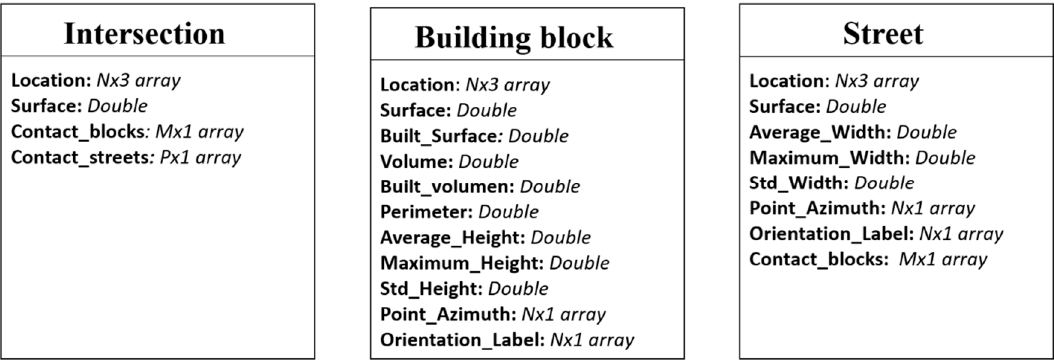
Figure 6. Three different classes with their respective properties are defined for storing information of the intersections, building blocks, and streets.